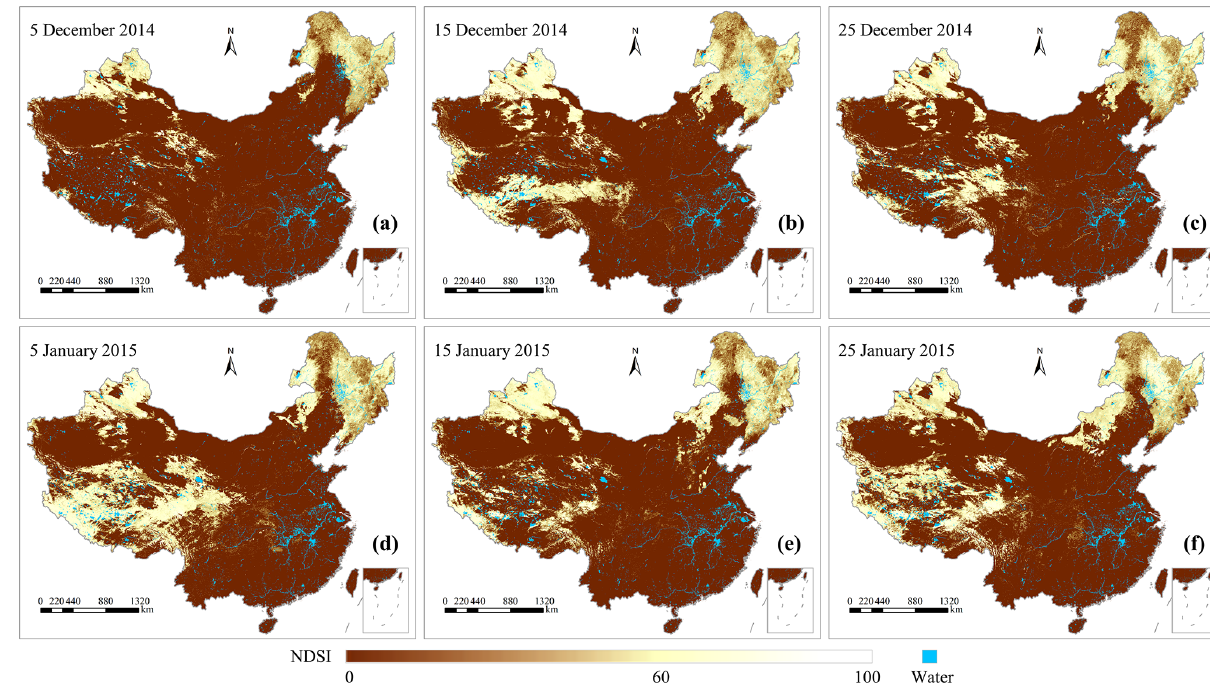
Figure 7. A sequence of the STAR NDSI collection from 5 December 2014 to 25 January 2015.